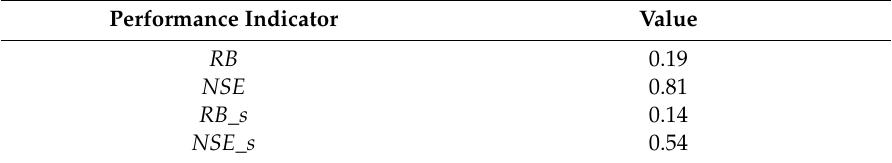
Figure 6. Observed versus modeled streamflow for the validation period by means of ( a ) the modified IHACRES model and ( b ) the original IHACRES model. Table 4. Performance indicators of the modified IHACRES model for the validation Table 5. Performance indicators of the original IHACRES model.